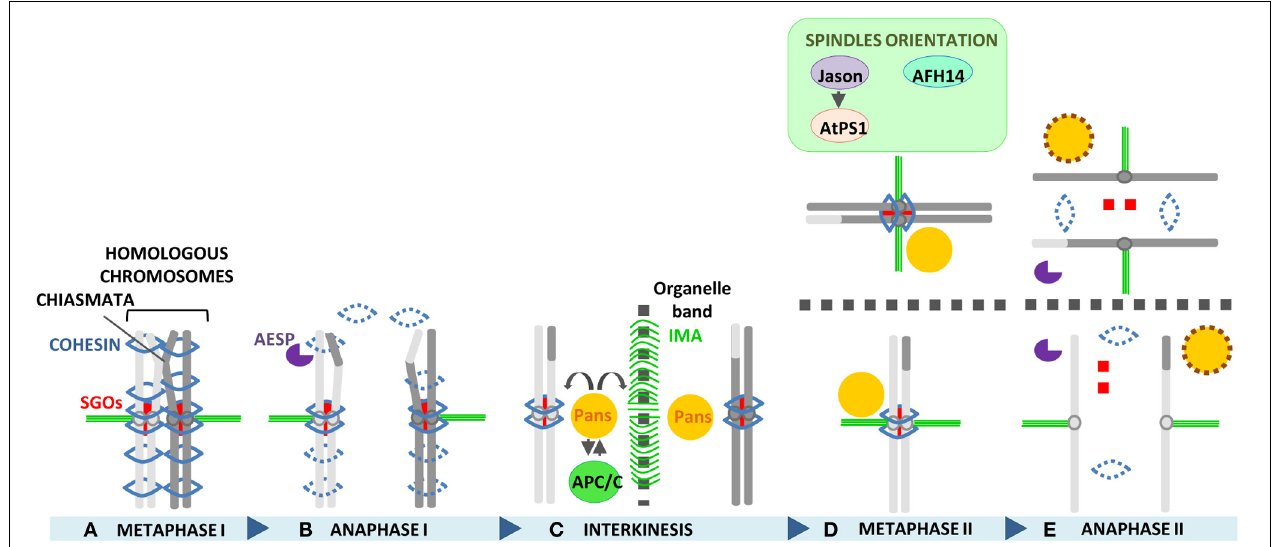
FIGURE 3 | Overview of chromosome segregation in Arabidopsis meiosis. (A) At metaphase I, homologous chromosomes are connected by chiasmata and SHUGOSHINs (AtSGOs) are present at the centromeres. (B) At anaphase I, Separase AESP is activated and cleaves the cohesin at chromosome arms but not at centromeres, allowing resolution of chiasmata and homologous chromosomes segregation by monopolar attachment to the spindles. (C) At interkinesis, an internuclear microtubule array (IMA) is formed at the site of the organelle band, to physically separate homologous chromosomes. PANS1 is active and